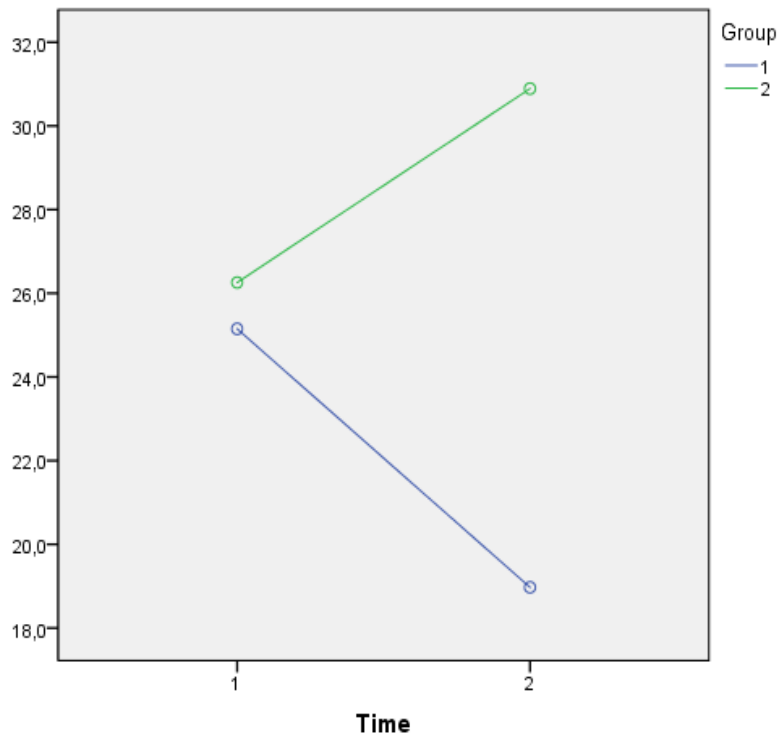
Figure 2. Comparison of the average CBI global scores in the EG (purple line) and in the CG over time (green